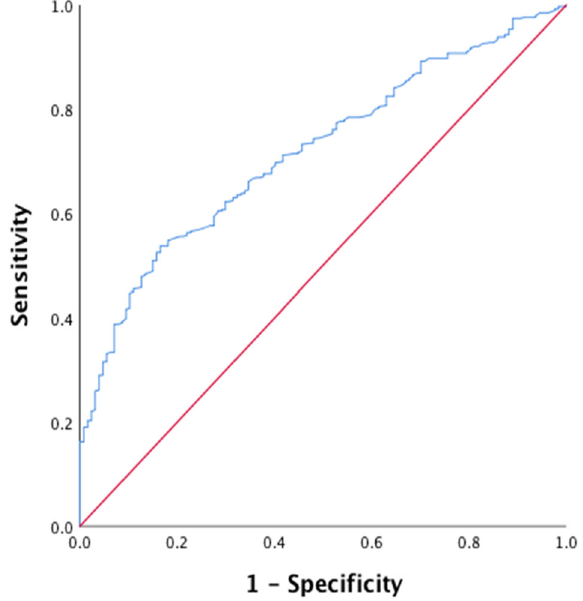
Fig. 2 The ROC curve for the TUG test. Diagnostic ability of TUG test against frailty in the patients with COPD. Frailty is de fi ned as frailty index ≥